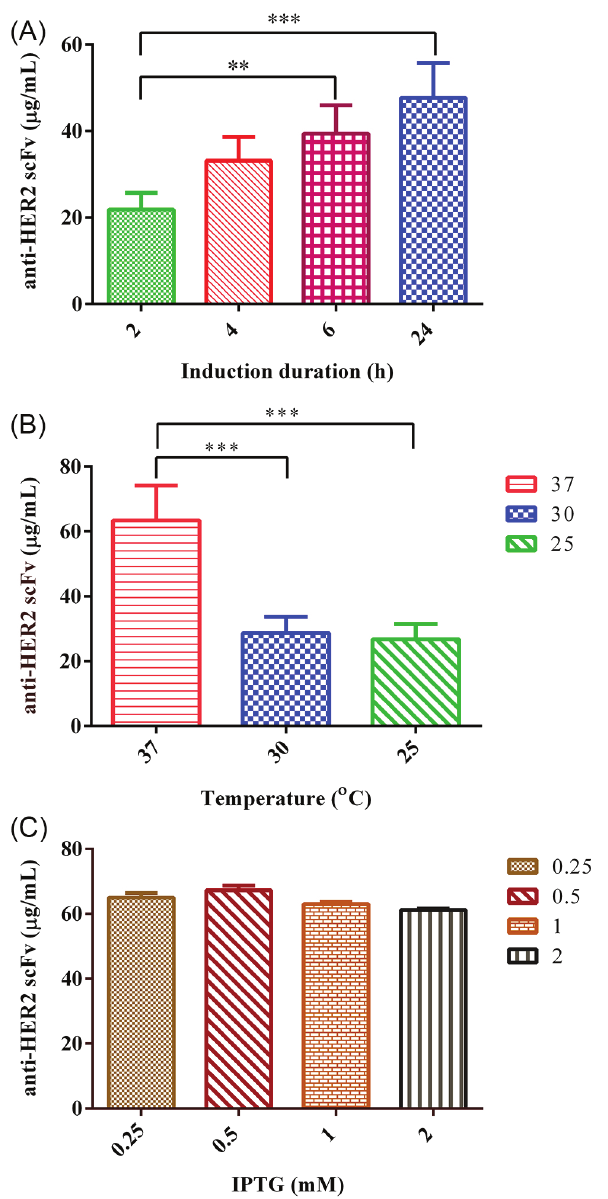
FIGURE 2 - Optimization of anti-HER2 scFv expression condition in Origami (DE3). A) The expression of anti-HER2 scFv protein at various harvesting times following IPTG induction (1 mM) at 37 °C. B) Anti-HER2 scFv expression at different temperatures induced by IPTG (1 mM) after 24 h. C) Induction of recombinant anti-HER2 scFv by different concentrations of IPTG at 37 °C for 24 h. Mean ± SD of two independent experiments was analyzed by ANOVA method. P <0.01 (**) and P <0.001 (***) were considered as the significant difference.